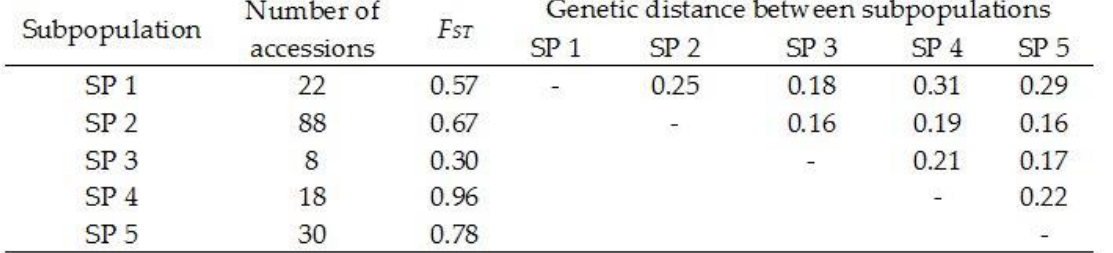
Figure 2. Population structure analysis based on 139 durum wheat accessions and 6280 SNP markers.